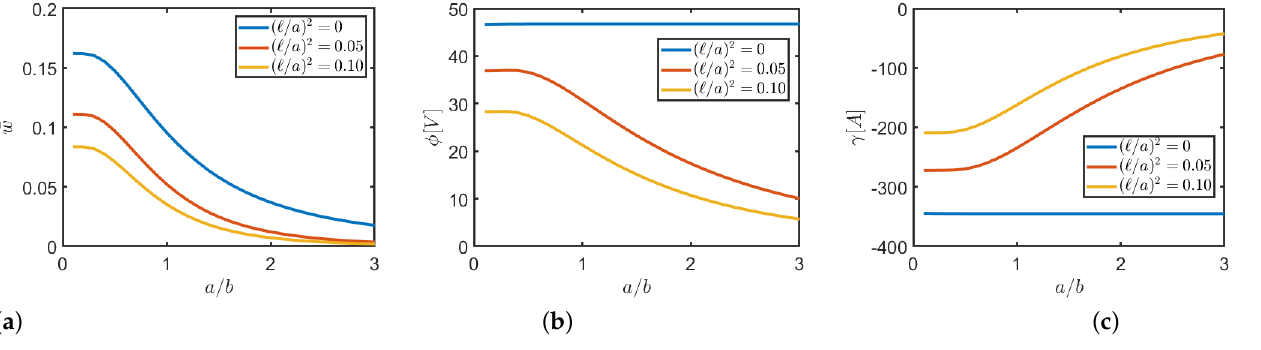
Figure 11. Graphs of displacement ¯ w ( a ) electric φ ( b ) and magnetic γ ( c ) potential, in the point ( a /2, b /2 ) to vary of a / b ratio and for different values of nonlocal parameter ( (cid:96) / a ) 2 and for n p = 1. (UDL; q = 0 N/m 2 , T 0 = T 1 = 0 K, ρ E = 0 C/m 2 , ρ H = 1 Wb/m 2